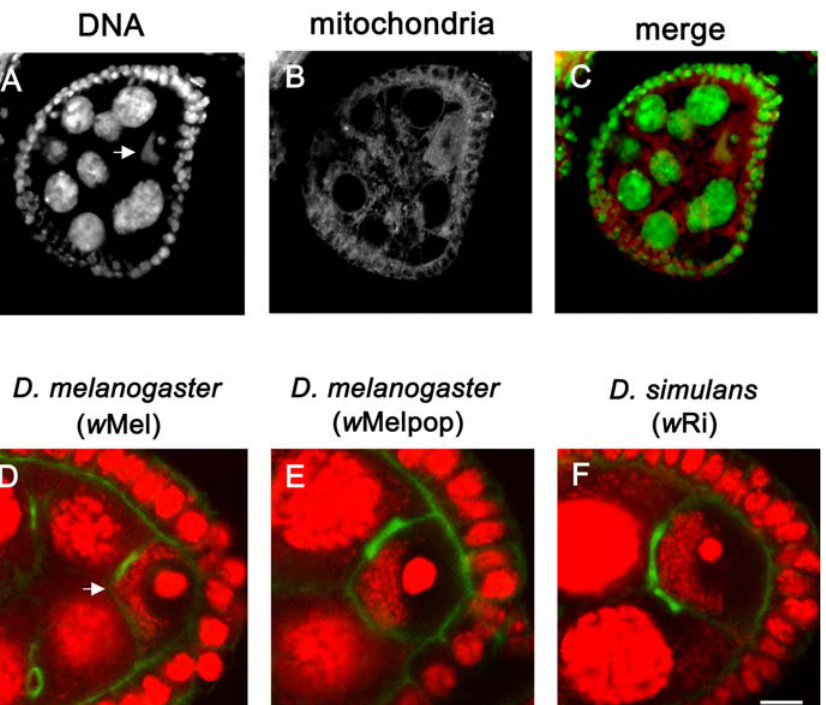
Figure 2. Wolbachia and Mitochondria Exhibit Different Localizations, and Wolbachia Anterior Localization Is Observed for Several Bacterial Strains and Drosophila Species (A–C) A stage 5 egg chamber showing Wolbachia and mitochondria. (A) Host DNA and Wolbachia (greyscale-OliGreen). (B) Mitochondria (greyscale- MitoTracker). (C) Merged image of (A) and (B): Wolbachia and host DNA are green and Mitochondria are red. (D–F) Wolbachia and host DNA are red (propidium iodide), and cell cortex and ring canals are green. (D) An oocyte from D. melanogaster infected with the w Mel Wolbachia strain. (E) An oocyte from D. melanogaster infected with the w Melpop (Popcorn) Wolbachia strain. (F) An oocyte from D. simulans infected with the w Riv Wolbachia strain. Scale bar ¼ 10 l m. White arrows in (A) and (D) indicate Wolbachia concentrated at the anterior region of the